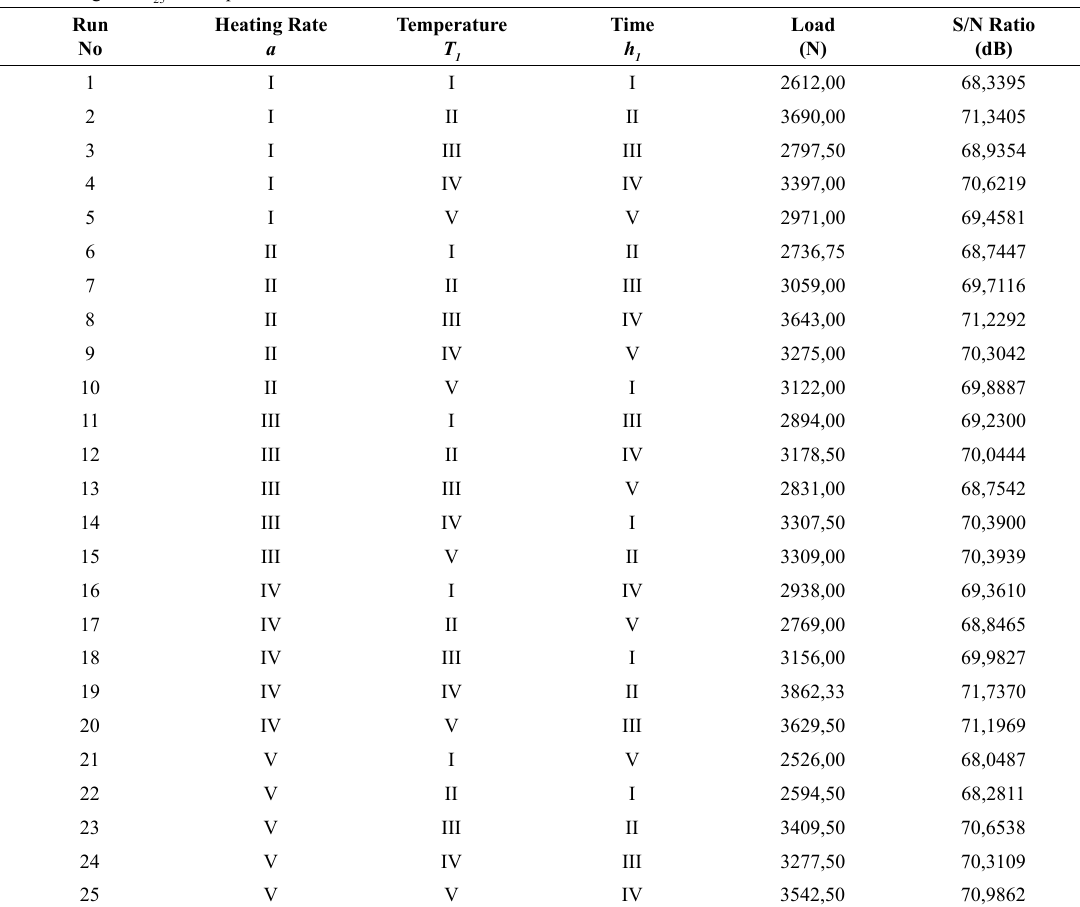
OA response values and S/N ratio for Load in Tensile tests. Table 3. Taguchi L 25